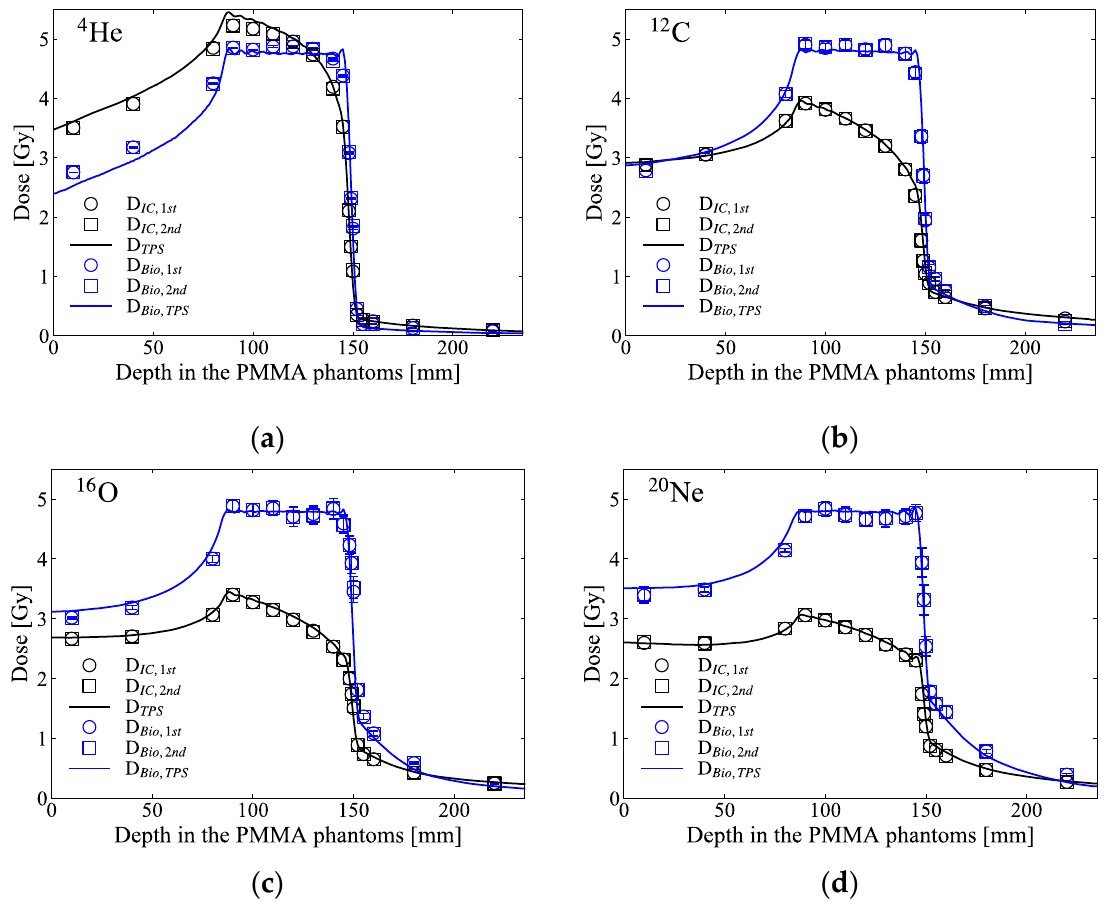
Figure 6. The blue markers show the biological dose along the SOBP of ( a ) 4 He-, ( b ) 12 C-, ( c ) 16 O-, and ( d ) 20 Ne-ion beams, calculated by means of multiplication of the physical doses and the RBE presented in Figure 5. The black square markers are the measured dose D IC presented in Figure 4. The black and blue solid lines indicate the planned physical and biological doses calculated by the TPS. Each error bar corresponds to the uncertainties of the biological dose evaluated from the error of lineal energy using error propagation.